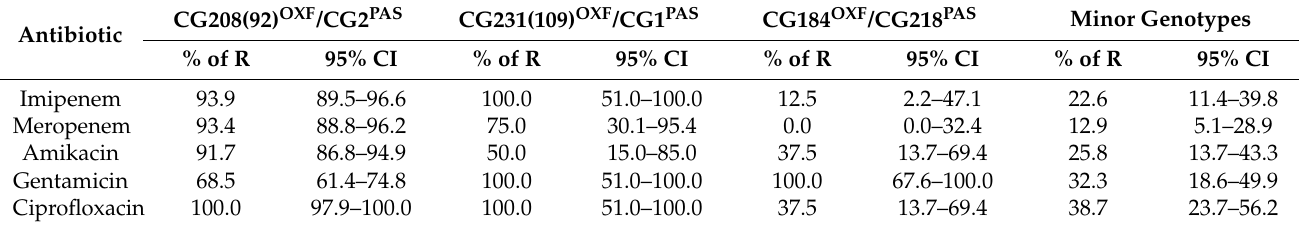
Table 3. Antibiotic resistance among isolates of different clonal